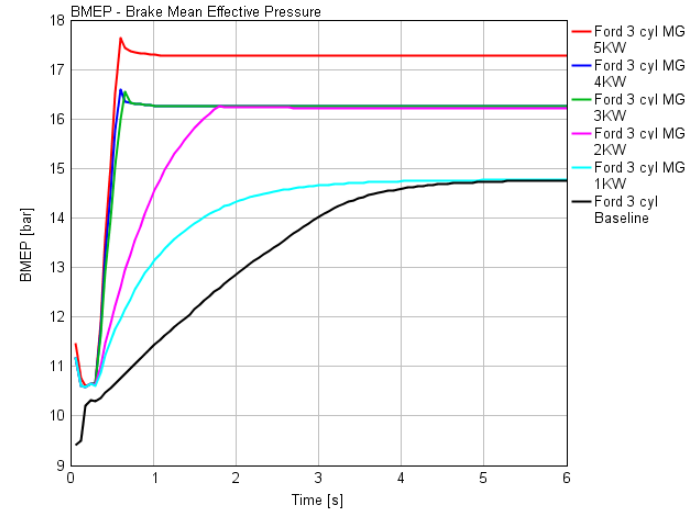
Figure 12. Brake mean effective pressure response time at 2000 rpm engine speed.